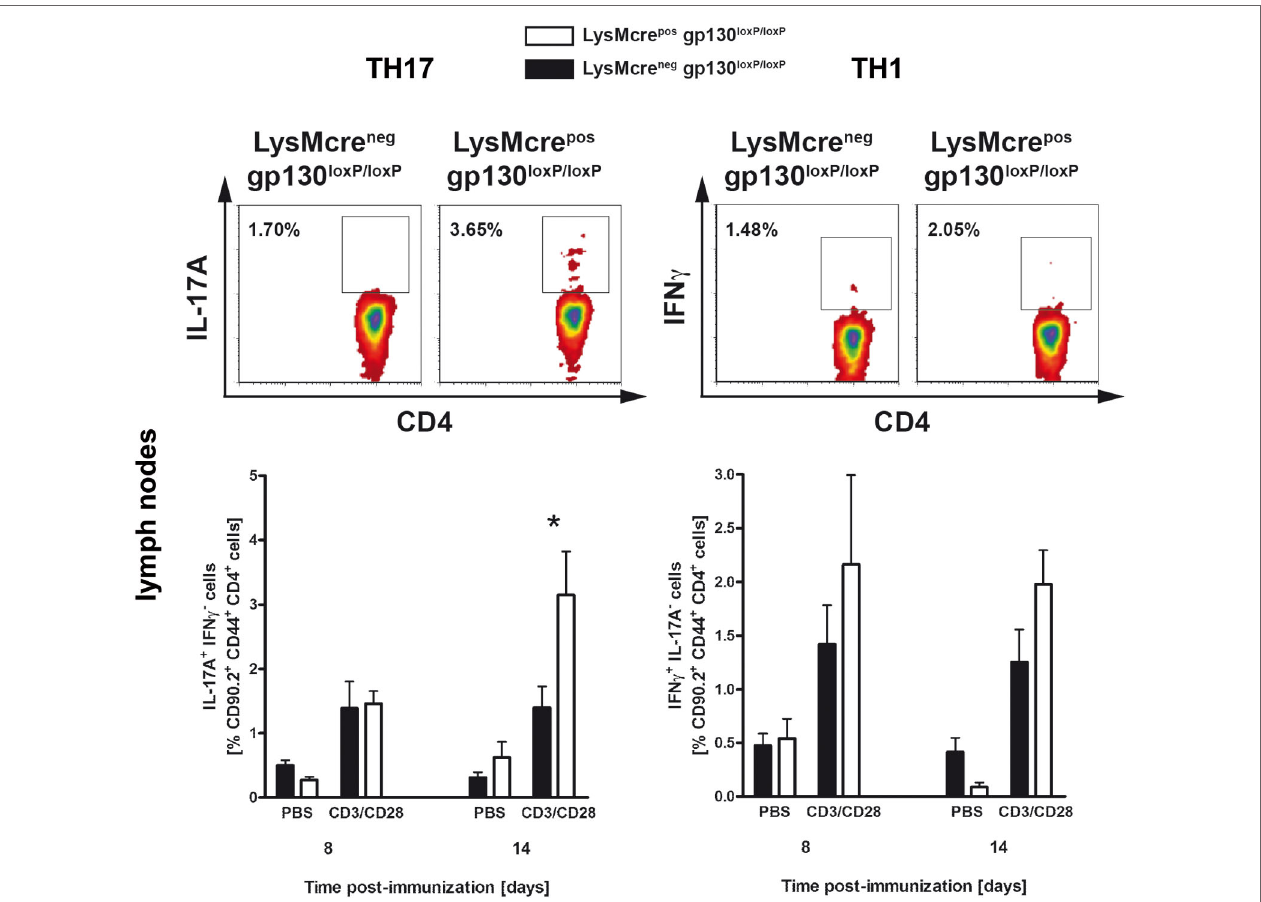
FigUre 5 | TH17 and TH1 immune responses in immunized LysMcre pos gp130 loxP/loxP mice and LysMcre neg gp130 loxP/loxP littermates. During the course of EAE, the frequency of TH17 and TH1 cells was determined by intracellular cytokine staining and subsequent flow cytometry. Analysis of intracellular IL-17A (left) and IFN γ production (right) by anti-CD3/CD28-stimulated cells is shown. For the analysis of TH17 and TH1 cells, single cell suspensions of the draining lymph nodes were performed at different time points (gated on CD90.2 + CD44 + CD4 + cells). Representative flow cytometry density plots of IL-17A- and IFN γ -producing cells isolated on day 14 are shown. Data represent means and SEs of five mice (day 8) and at least four mice (day 14) per group, respectively. One experiment representative out of two performed is shown. Statistical analysis was performed using Mann–Whitney test. Asterisks indicate statistical significance (* p ≤